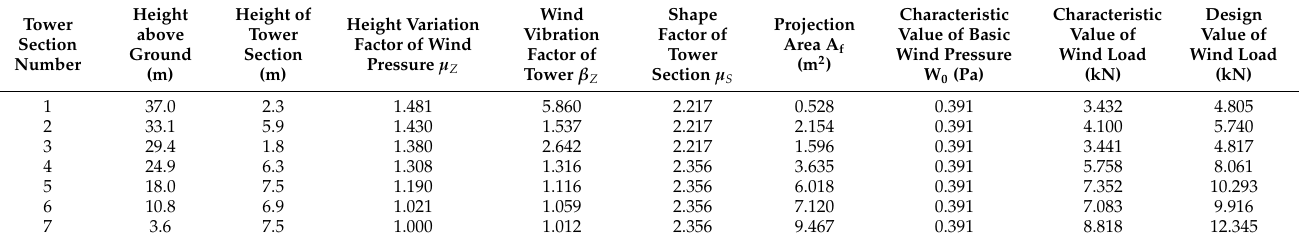
Table 3. Wind loads of tower sections (the wind speed is 25 m/s and the wind direction angle is 90 ◦ ).